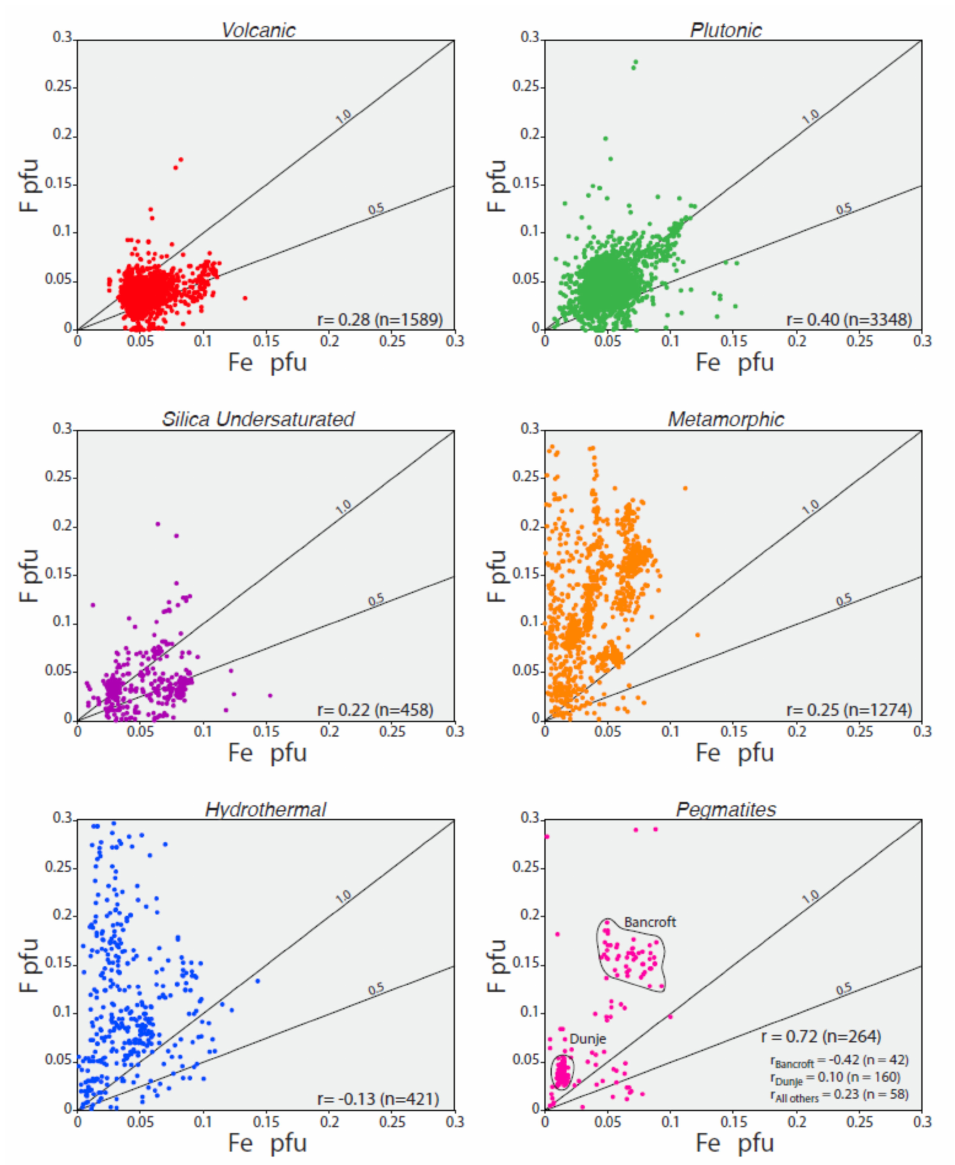
Figure 31. Fe versus F in titanite from various environment. The correlation coefficients (r) and number of analyses (n) in each group are